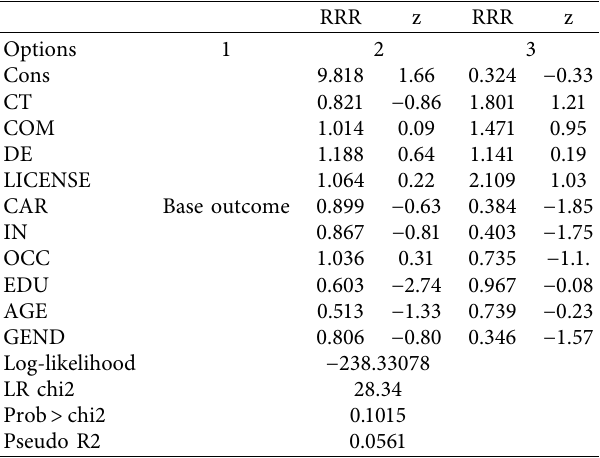
Table 7: Estimation results of the discrete choice model without considering the latent